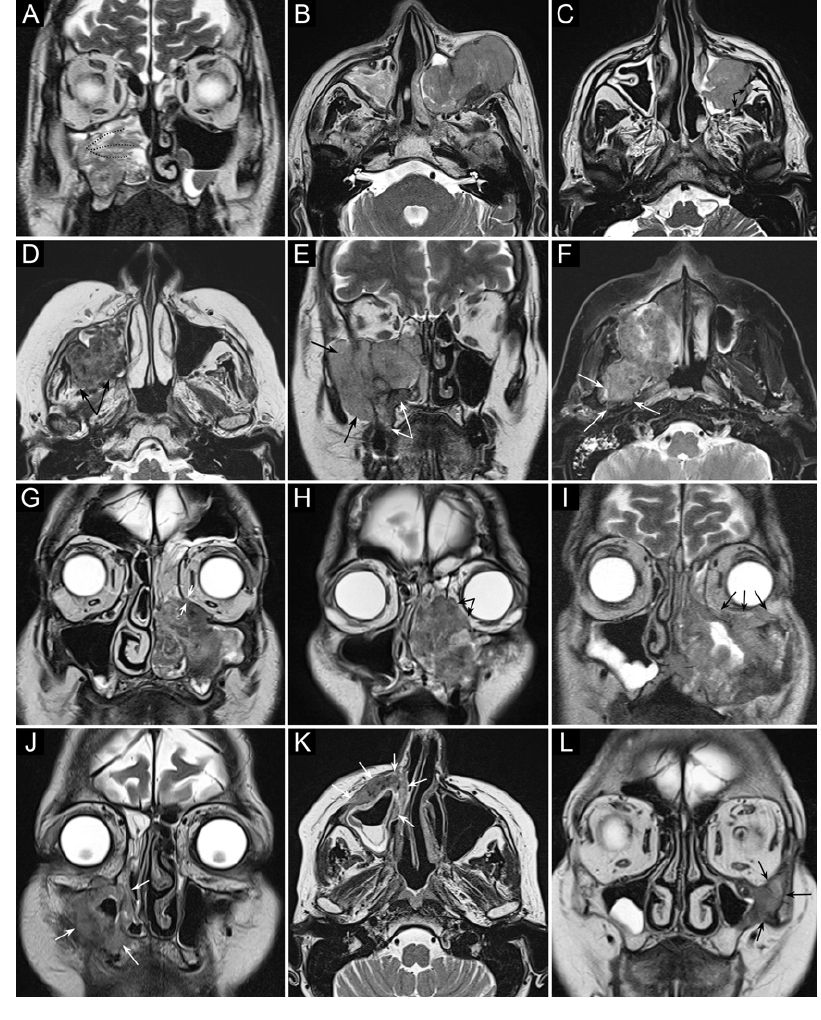
Figure 2. Panel summarizing several patterns of local extension of maxillary squamous cell carcinoma (SCC) and other epithelial cancers. ( A ) SCC ex inverted papilloma limited to the right maxillary sinus. A quite regular striated appearance indicates the papilloma (dotted curved lines). ( B ) Poorly differentiated SCC of the left maxillary sinus with massive infiltration of premaxillary tissues. ( C ) Spindle-cell SCC of the left maxillary sinus with initial infiltration of the fat pad located within the infratemporal fossa (arrows). ( D ) Moderately differentiated SCC of the right maxillary sinus with massive infiltration of the infratemporal fossa (arrows). ( E ) Neuroendocrine carcinoma of the right maxillary sinus infiltrating the ipsilateral nasoethmoidal compartment and alveolar process (white arrows), and massively invading the infratemporal and temporal fossae (black arrows). ( F ) Poorly differentiated SCC of the right maxillary sinus invading the infratemporal fossa, medial and lateral pterygoid muscle, and the upper parapharyngeal space (arrows). ( G ) Poorly differentiated SCC of the left maxillary sinus with initial orbital encroachment; the T2-hypointense line separating the tumor from the extraconal fat is partially interrupted, suggesting initial invasion of the extraconal compartment (arrows). ( H ) Moderately differentiated, keratinizing SCC of the left maxillary sinus with orbital involvement; a T2-hypointense line separating the tumor from the extraconal fat cannot be depicted (arrows). ( I ) Poorly differentiated SCC of the left maxillary sinus with massive invasion of the extraconal fat (arrows). ( J – L ) Three examples of SCC of the maxillary sinus with permeative bone invasion, which consists of cancer progressing within bone structures while partially maintaining their initial shape (arrows).